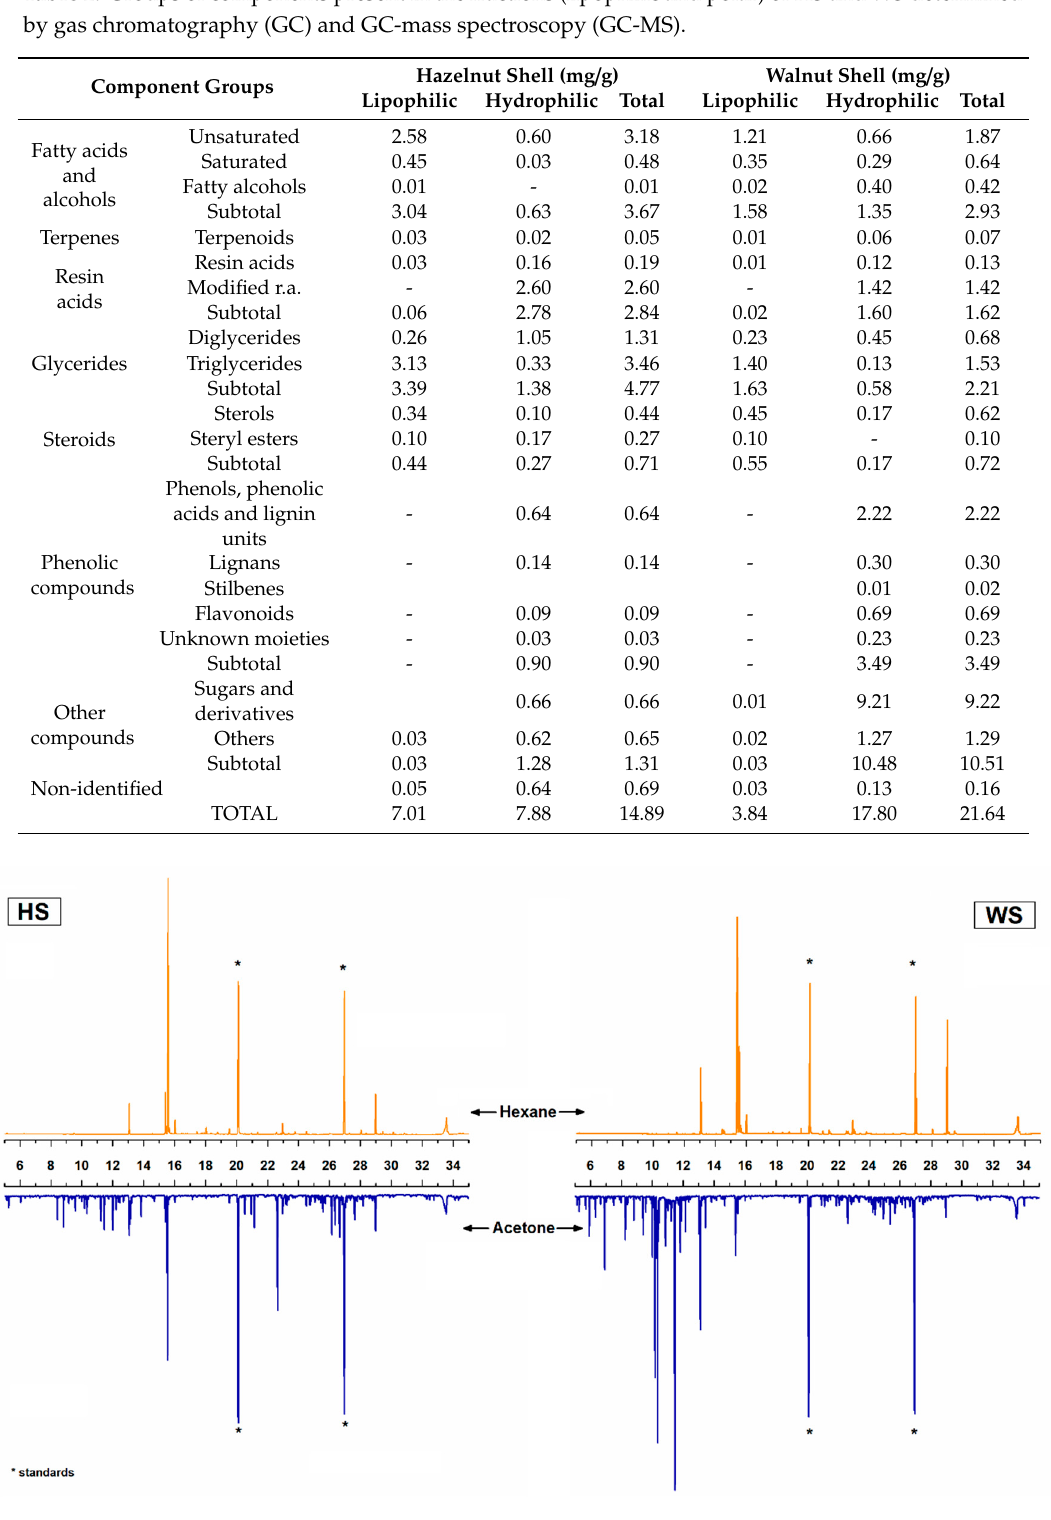
Figure 2. Classical GC column chromatograms of the lipophilic and hydrophilic fractions of hazelnut shell (HS) and walnut shell (WS) extracts.